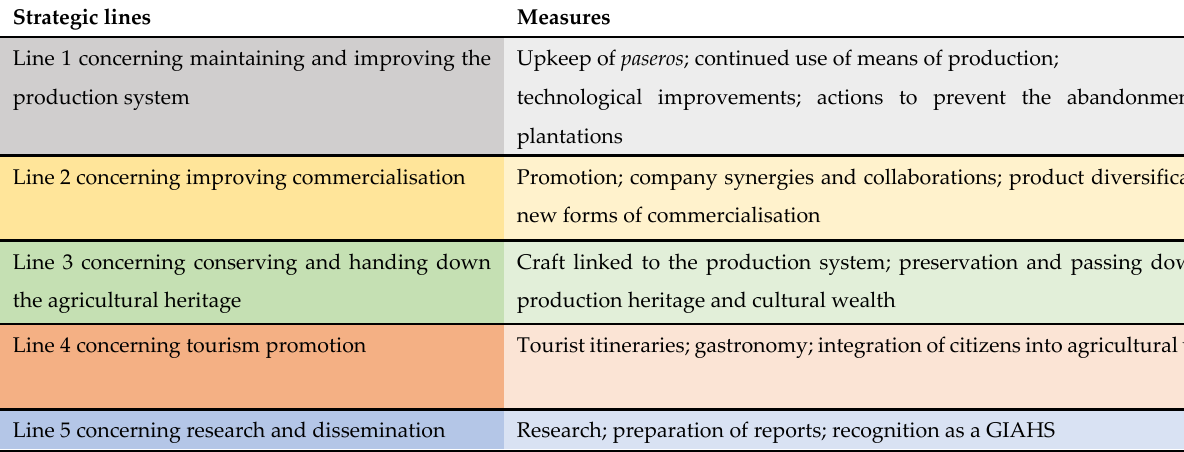
authors, based on Figure 9. Strategic lines and measures of the Malaga Raisin GIAHS Action Plan. Source: Prepared by authors, based on [16].